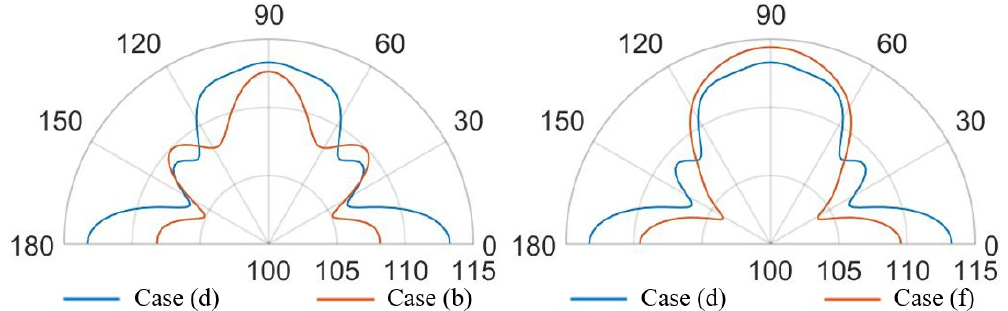
Figure 27. SPL polar plot (dB) at the performing fundamental frequency of 85.5 kHz (10 V bias), at 3.5 cm in the y(90 ◦ )–z(0 ◦ ) plane: (d) vs (b) ( left ), (d) vs (f) ( right